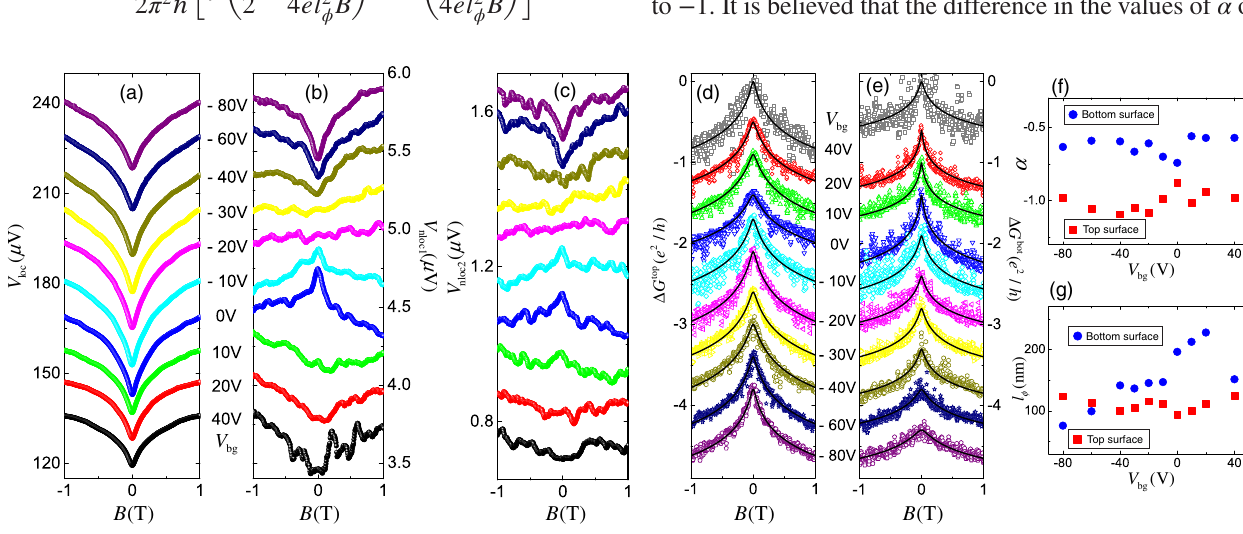
FIG. 5. V dependence of (a) V vs B , (b) V vs B , and (c) V vs B . Each curve is shifted vertically for clarity. The universal bg loc nloc 1 nloc 2 conductance fluctuations are conspicuous in V . (d),(e) Simulation results of Δ G top □ ¼ G top □ ð B Þ − G top □ ð B ¼ 0 Þ and Δ G bot □ ¼ nloc 1 ; 2 G bot □ ð B Þ − G bot □ ð B ¼ 0 Þ for a given V . The solid lines in (d) and (e) are the best fits to Eq. (1). Each set of data, together with the fitting bg curve, is shifted vertically for clarity. (f),(g) V dependence of α and l ϕ obtained from the best fits to Eq. (1). Squares (circles) bg correspond to the top (bottom)